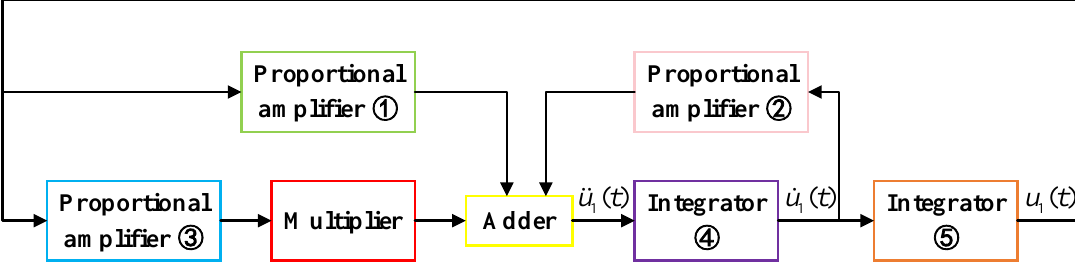
Figure 11. Equivalent circuit model of resonant beam with comb